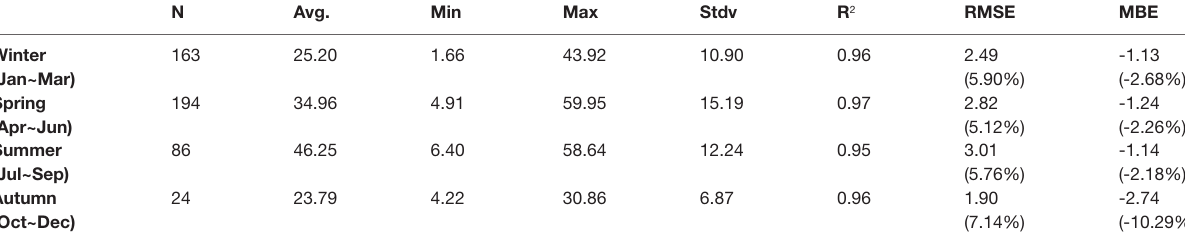
TABLE 3 Seasonal statistics from corrected GOCI daily